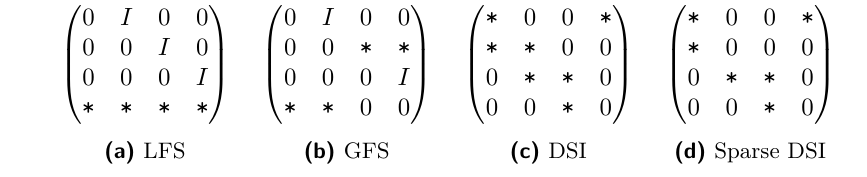
Figure 1: Types of iterative MDS